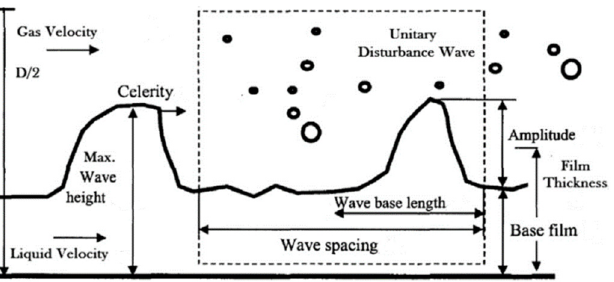
Figure 3. A schematic representation of spatial feature of large amplitude travelling waves adopted from Berna et al. [48].